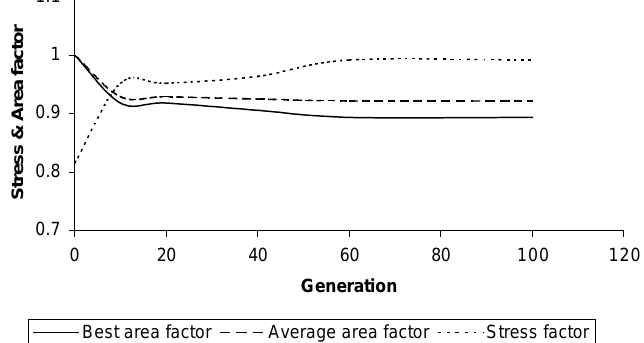
Fig. 17. Genetic evolution of stress and area factor for the simply supported beam.